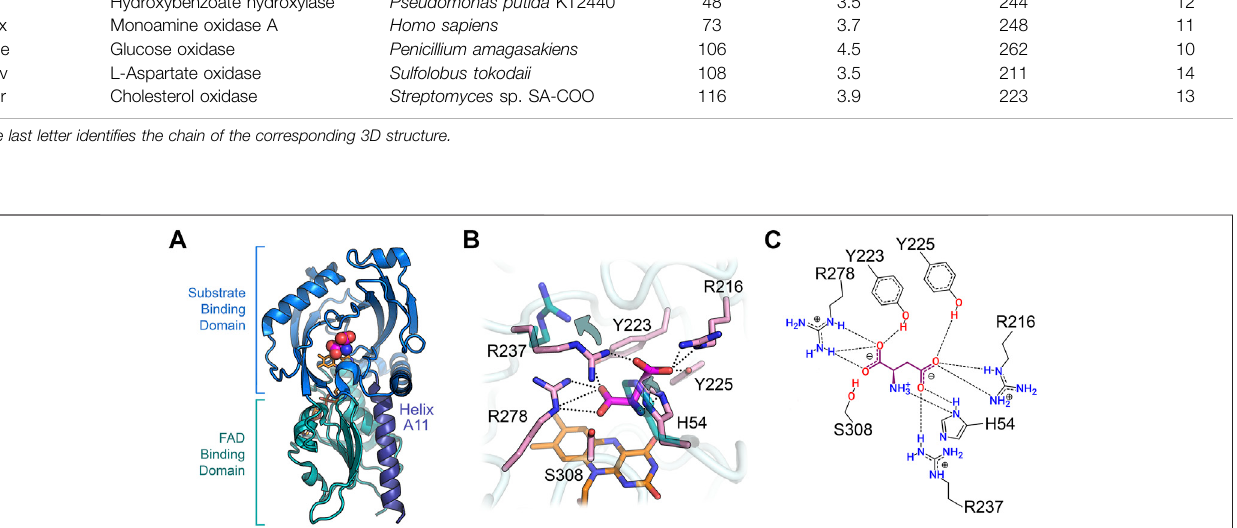
Table 2 . The tertiary structure of hDASPO can be divided into two large domains, each formed by noncontiguous sequence regions: the FAD-binding domain (FBD) and the substrate-binding domain (SBD), Figure 4A . The FBD possesses the canonical dinucleotide binding fold (i.e., the